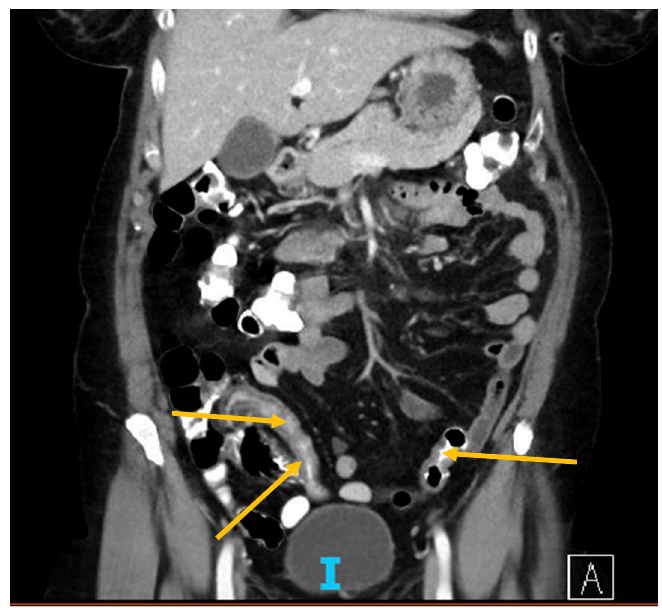
Figure 2. CT of abdomen and pelvis showing sigmoid colon thickening (arrows).